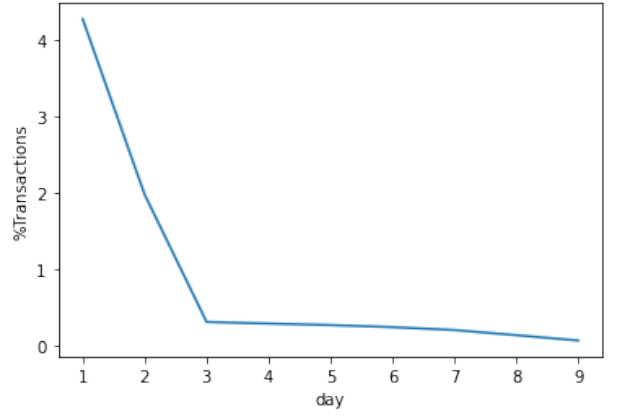
Figure 7. Different percentage of transaction between our solution and a naive